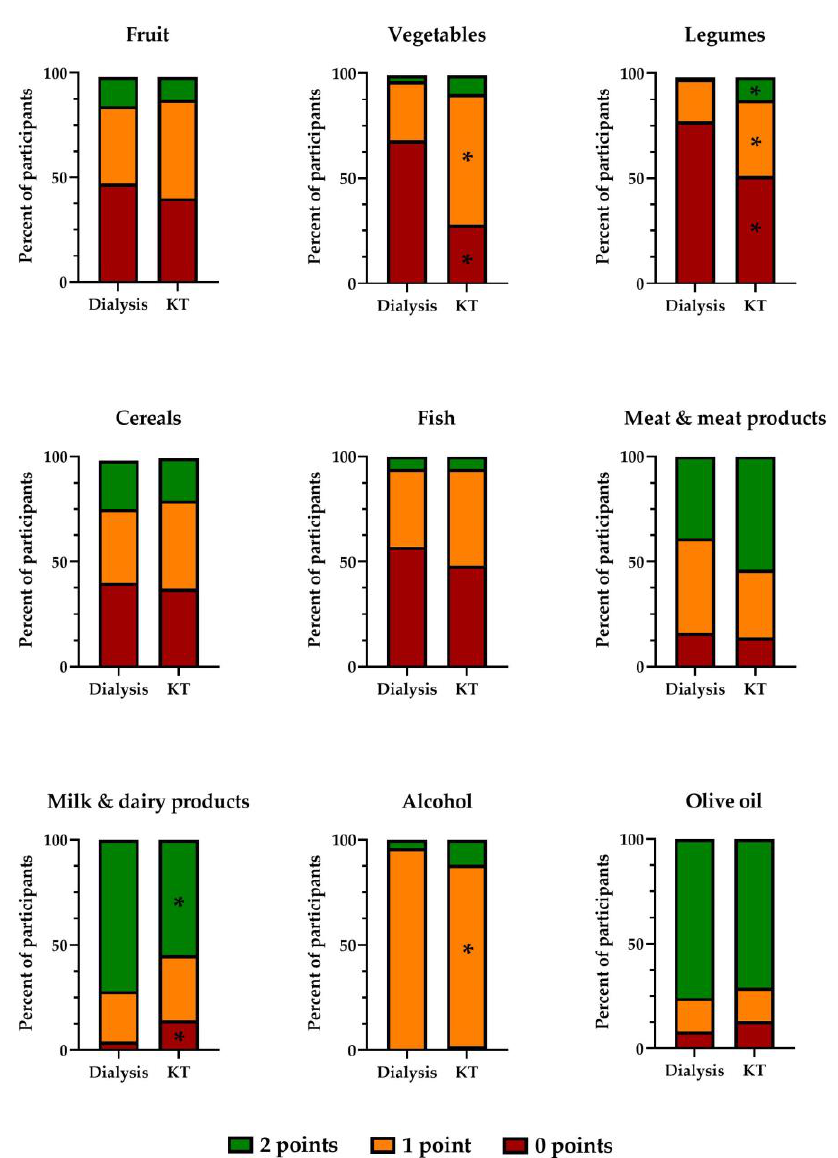
Figure 5. Proportion of participants reporting optimal (2 points), intermediate (1 point), or inadequate (0 points) intake of each food category included in the MEDI-LITE questionnaire. * p < 0.05 vs. the corresponding category in the dialysis